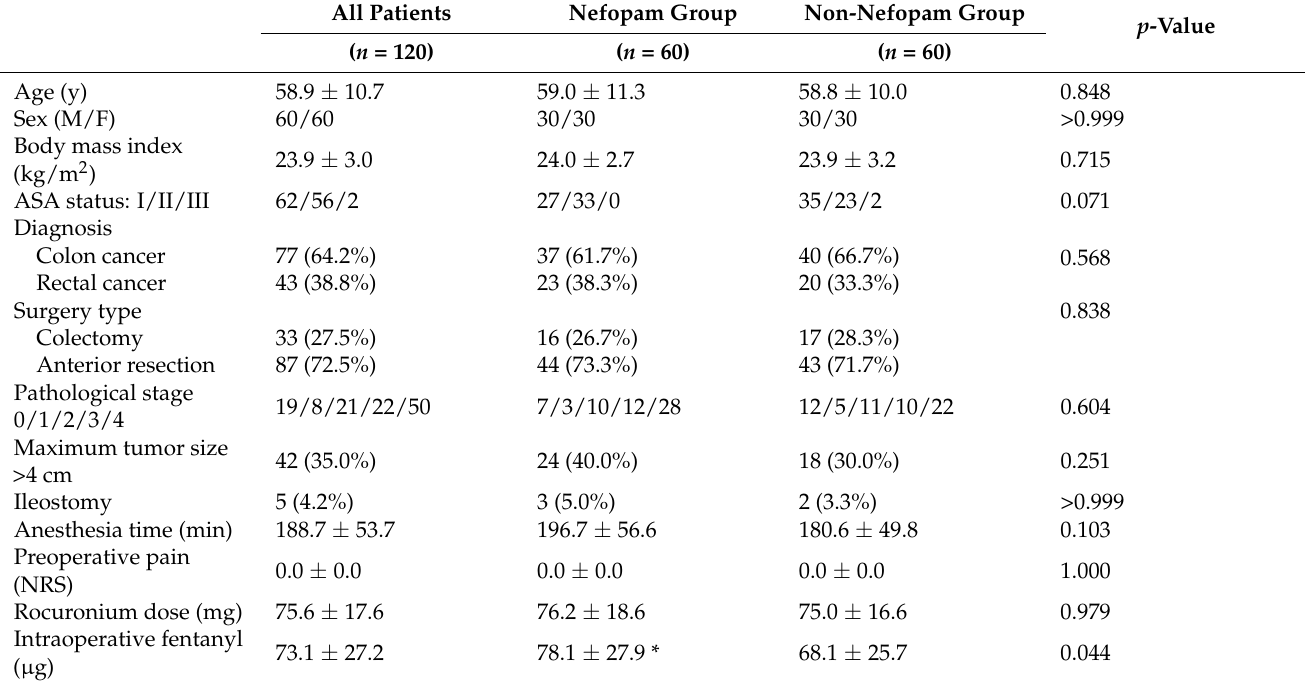
Table 1. Demographic and clinical data.